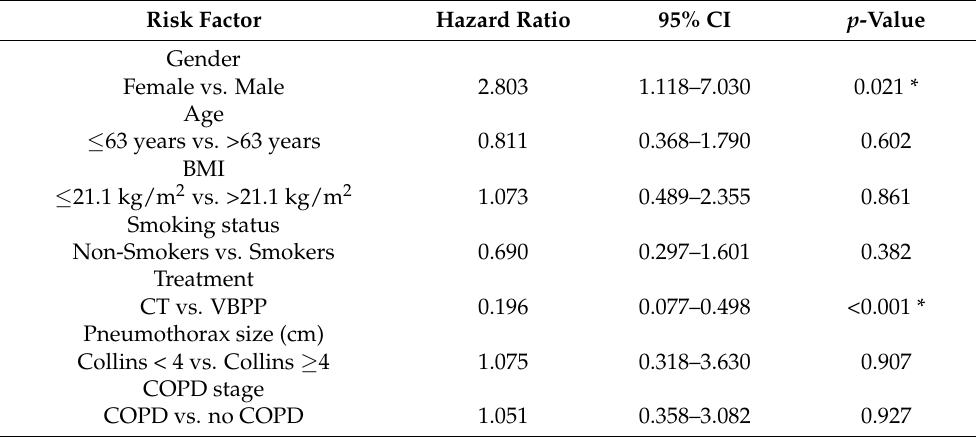
Table 3. Univariate analysis of potential risk factors for recurrence of SSP.